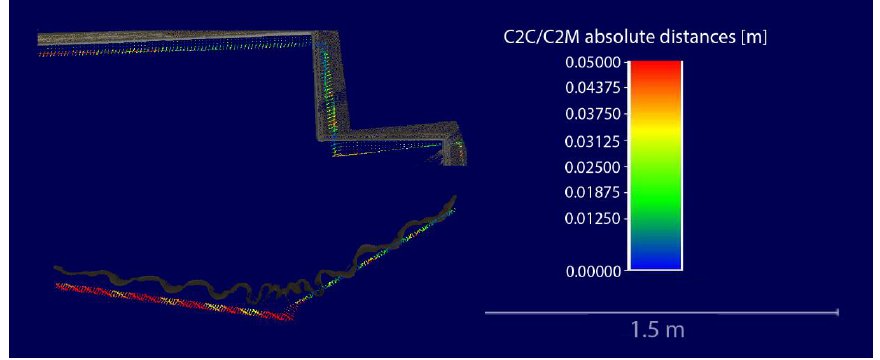
Figure 5. Detail of the walls in the hall 101 ( top ) and Tetra ( bottom ) Theta V point clouds in comparison to the reference point cloud, shown in original color.